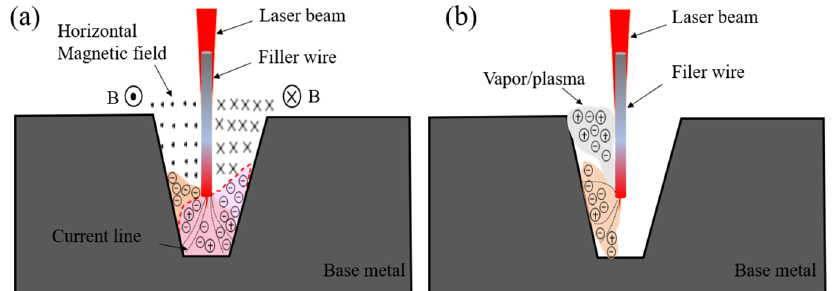
Figure 4. Schematic diagram of arc plasma behavior of narrow gap groove: ( a ) with alternating magnetic field; ( b ) without magnetic field. (B: magnetic flux density)